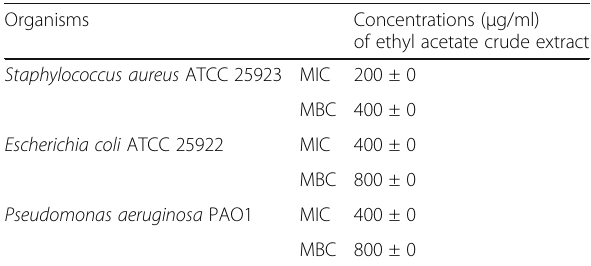
Table 2 Minimum inhibitory concentration (MIC) and Minimum bactericidal concentration (MBC) Organisms Concentrations ( μ g/ml) of ethyl acetate crude extract